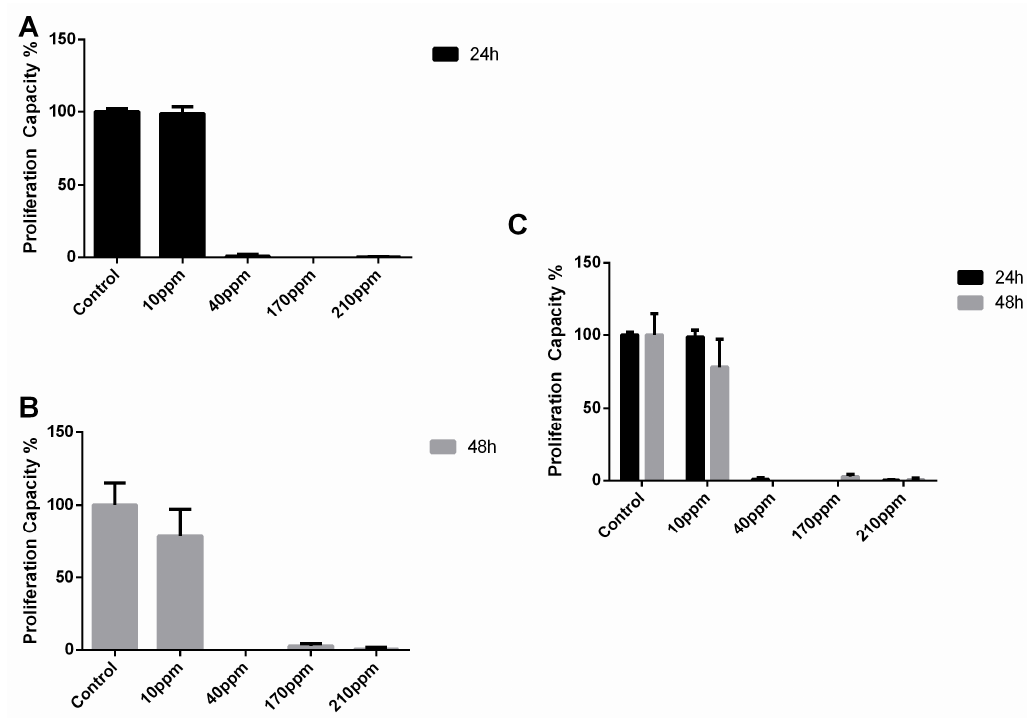
Figure 9. Effect of AgNPs at concentrations of 10–210 ppm, on PC-3 cell proliferation assessed by BrdU incorporation assay after 24 h ( A ) and 48 of treatment ( B ). and the comparison between their effect at the two time points ( C ). Results are expressed as percentage of control (untreated cells) considered as 100%, as mean ± SEM.